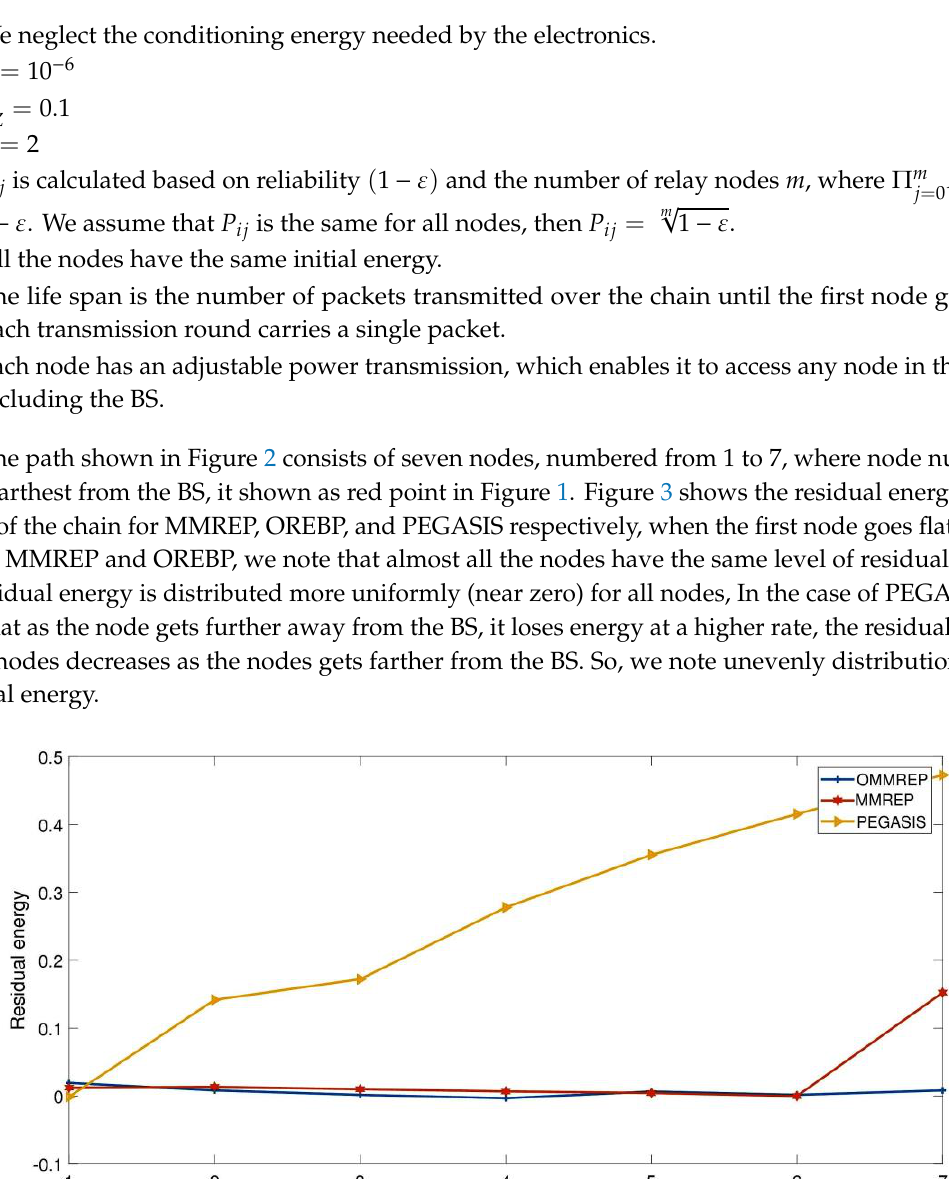
Figure 4. Life span with different data loss (𝜀) .